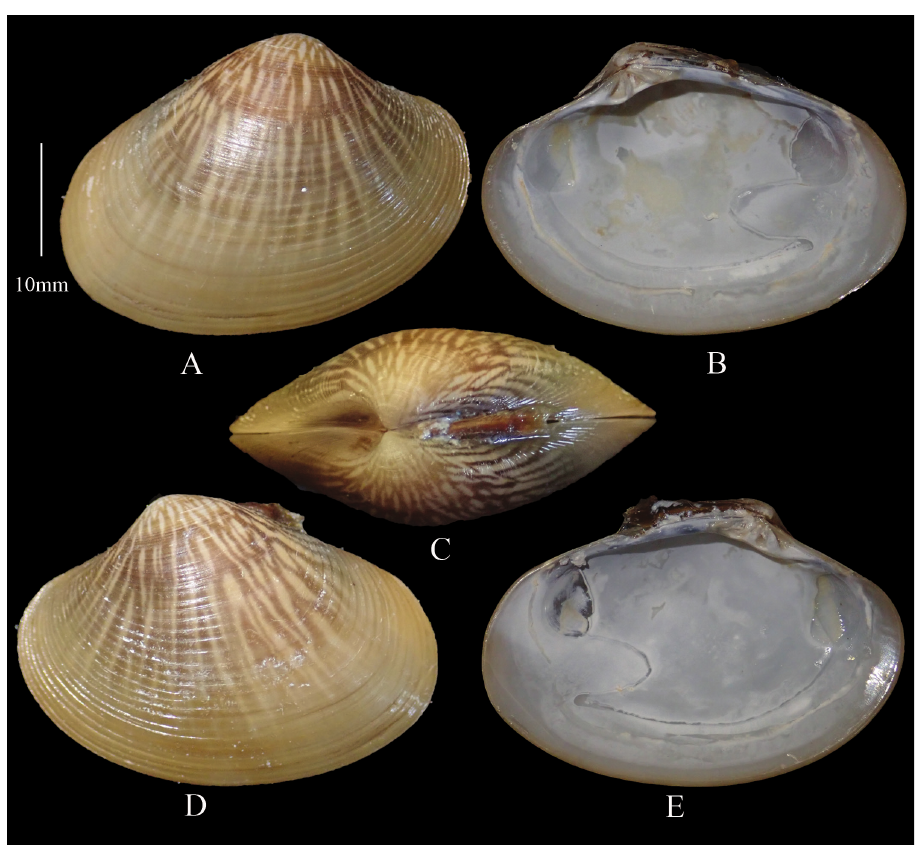
Figure 9. Marcia recens Morphotype 5 A right valve dorsal B right valve ventral C dorsal margin D left valve dorsal E left valve ventral (DABFUK), Ashtamudi Lake,